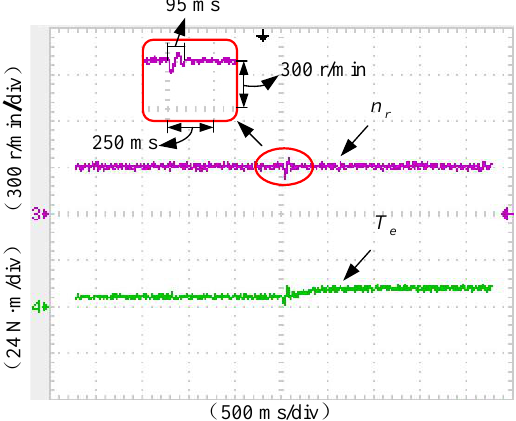
Figure 20. Dynamic performance of RDTC without TIBC ( P = 9.5, I = 1.1).